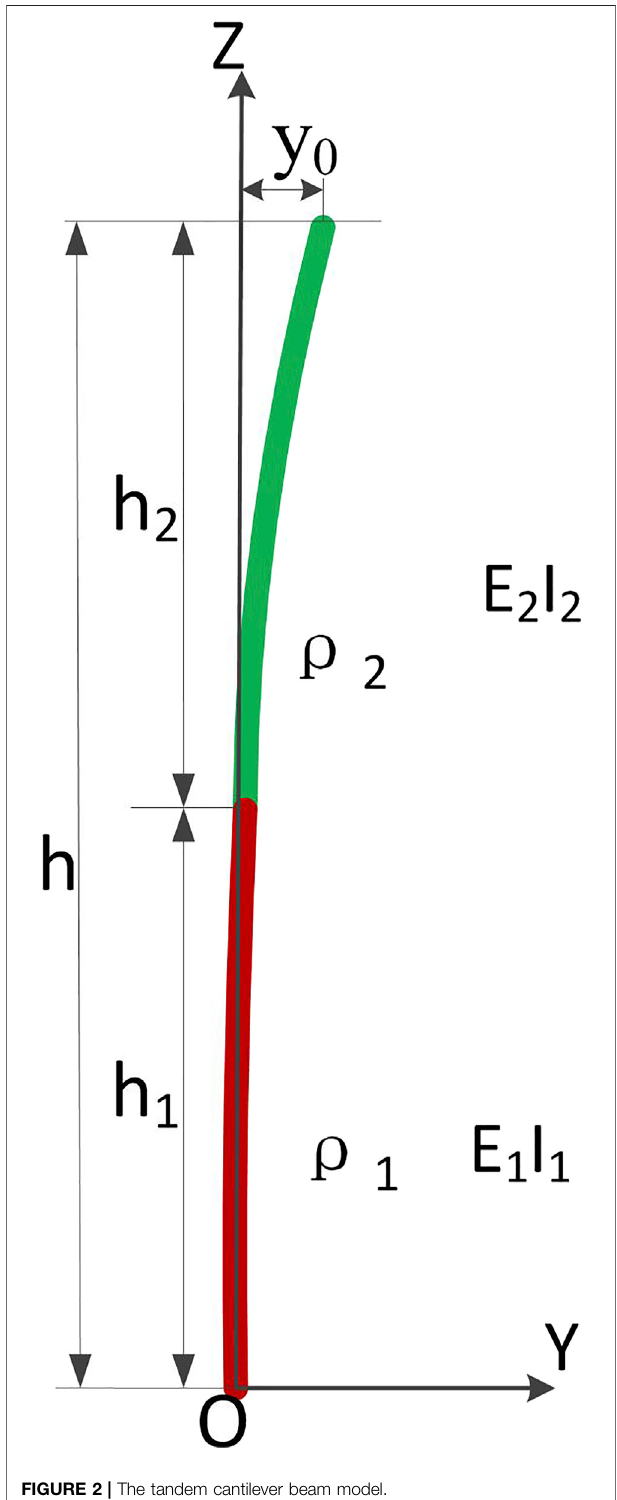
(1 ) FIGURE 2 | The tandem cantilever beam